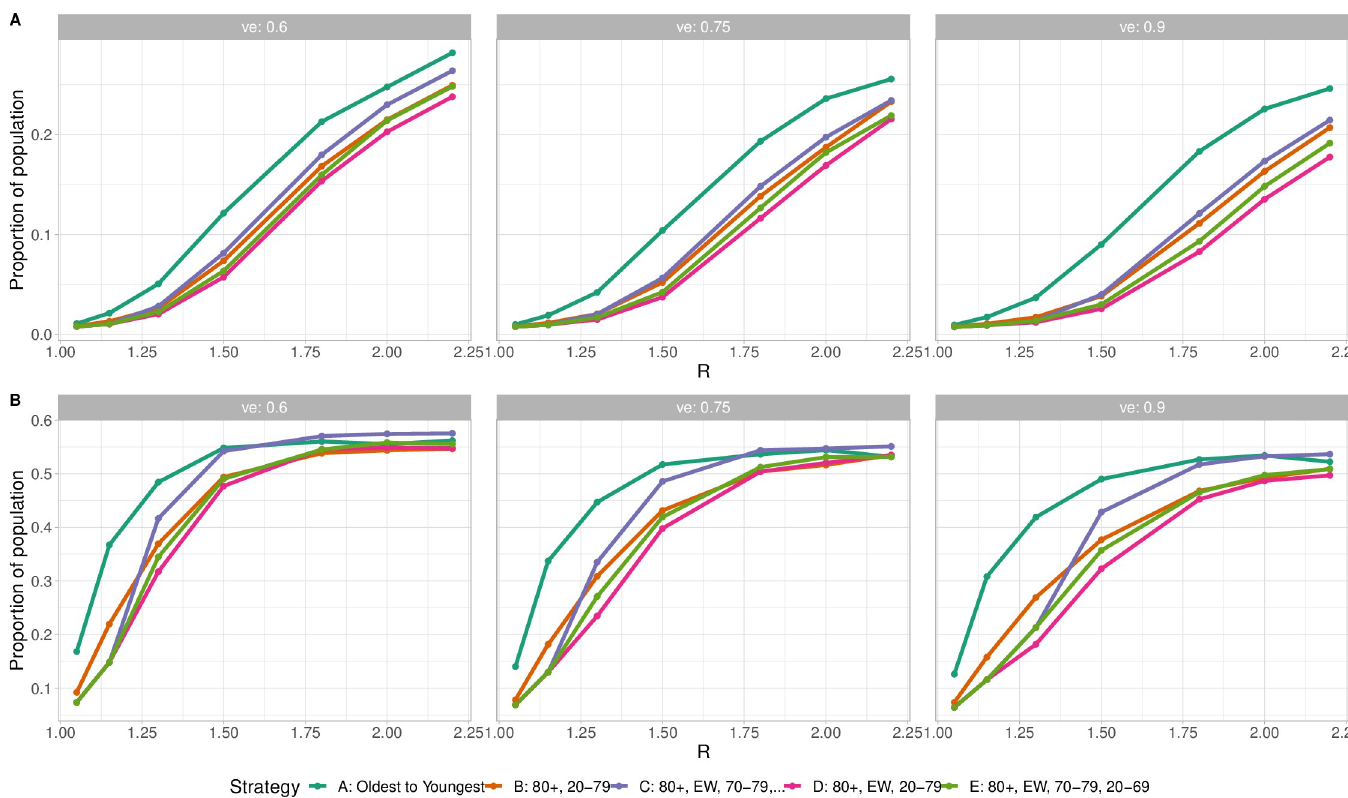
Fig 5. Immunity and vaccination at the time when infections begin to decline (turn around time), as a function of R . (A) Proportion ever infected by turn around time. (B) Proportion ever infected or vaccinated by turn around time. The efficacy of vaccination against infection ( v